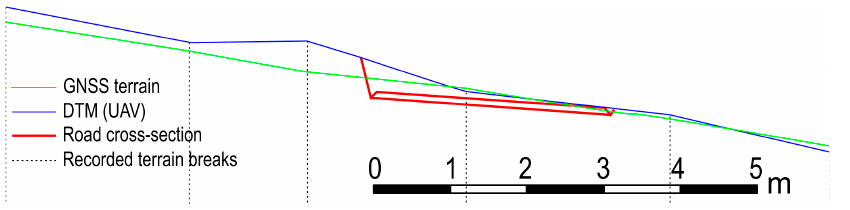
Figure 8. Illustrative representation of the forest/skid road profile for different 3D terrain inputs and deviations that occur when observing the surface, i.e., all terrain breaks in the cross-section.